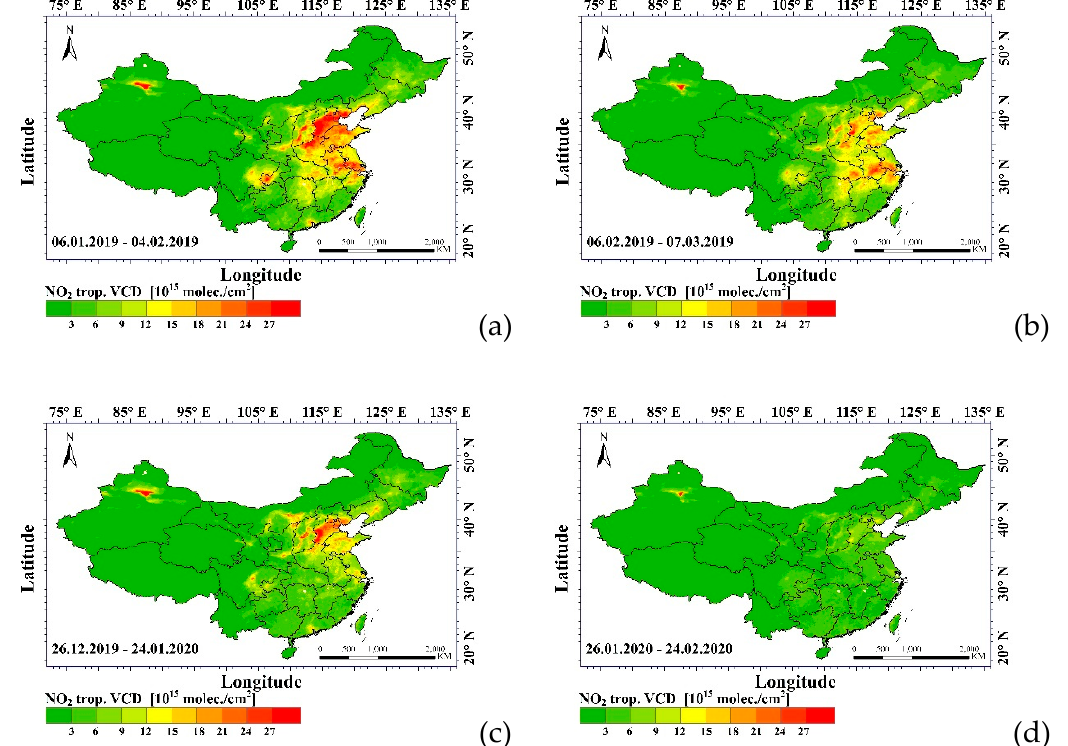
Figure 2. NO 2 tropospheric vertical column density averaged over 30 days: ( a ) before the 2019 Spring Festival; ( b ) after the 2019 Spring Festival; ( c ) before the 2020 Spring Festival; ( d ) after the 2020 Spring Festival.